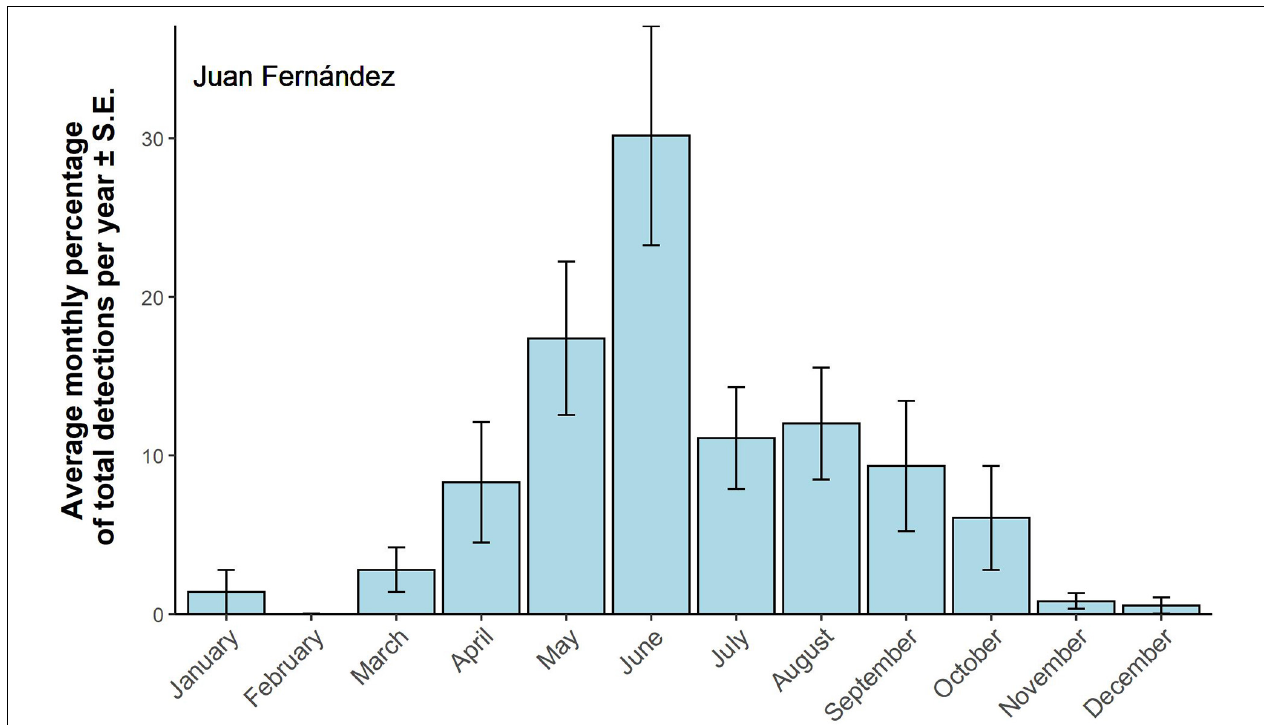
FIGURE 7 | Antarctic Blue whale detections at Juan Fernández. Averaged monthly detections ± SE. Monthly detections have been standardized by calculating the monthly percentage of total detections per year. Monthly detections were averaged over 10 years of available data.